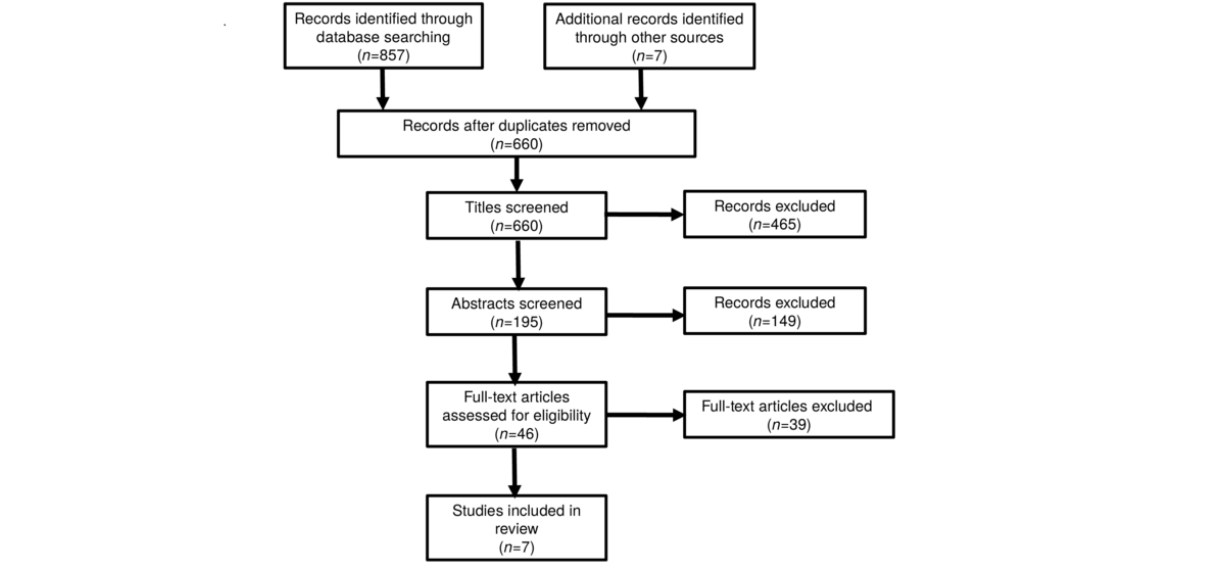
Figure 2. Process of identification and selection of included studies. Databases used were Cochrane Central Register of Controlled Trials